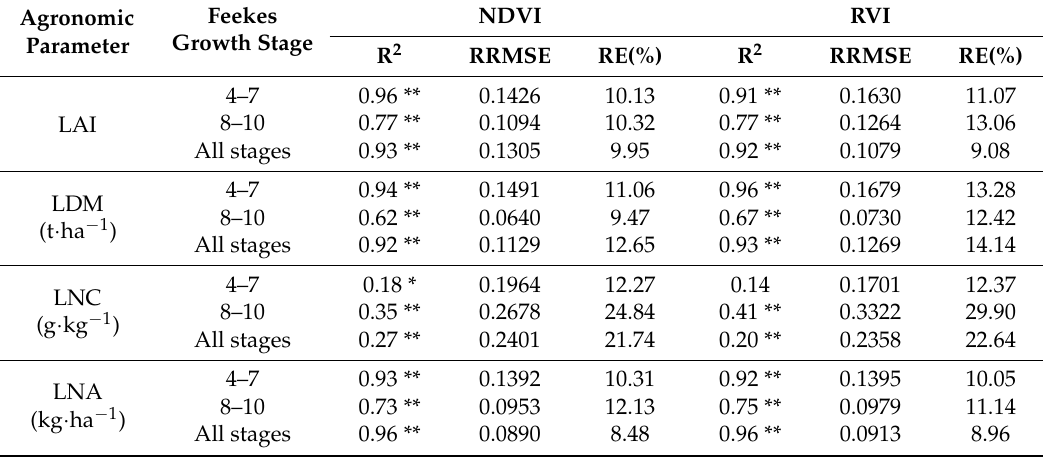
Table 5. Validation of the GreenSeeker indices for estimating LAI, LDM, LNC, and LNA at different wheat growth